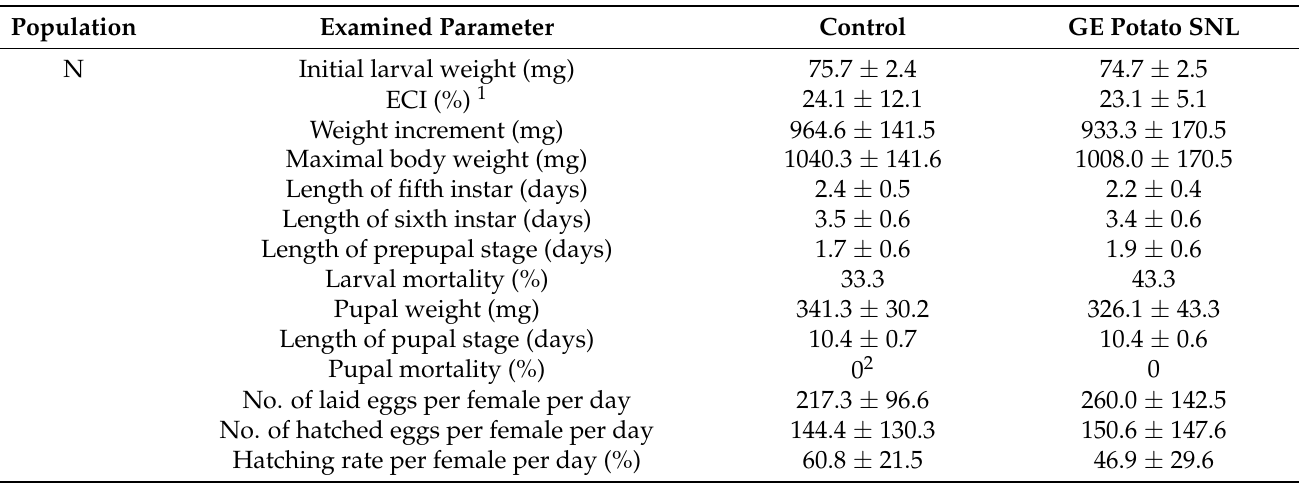
Table 2. Examined parameters (mean ± SD) of fiv e S. littoralis populations in bioassay 3 with Cry3Aa expressed in GE potato SNL. Different letters (in bold) denote statistically significant differences, while letters were not assigned when statistical difference was not found. The values of statistical tests are available in Table S2C. Abbreviation in the table—for details, see Section 5, Materials and